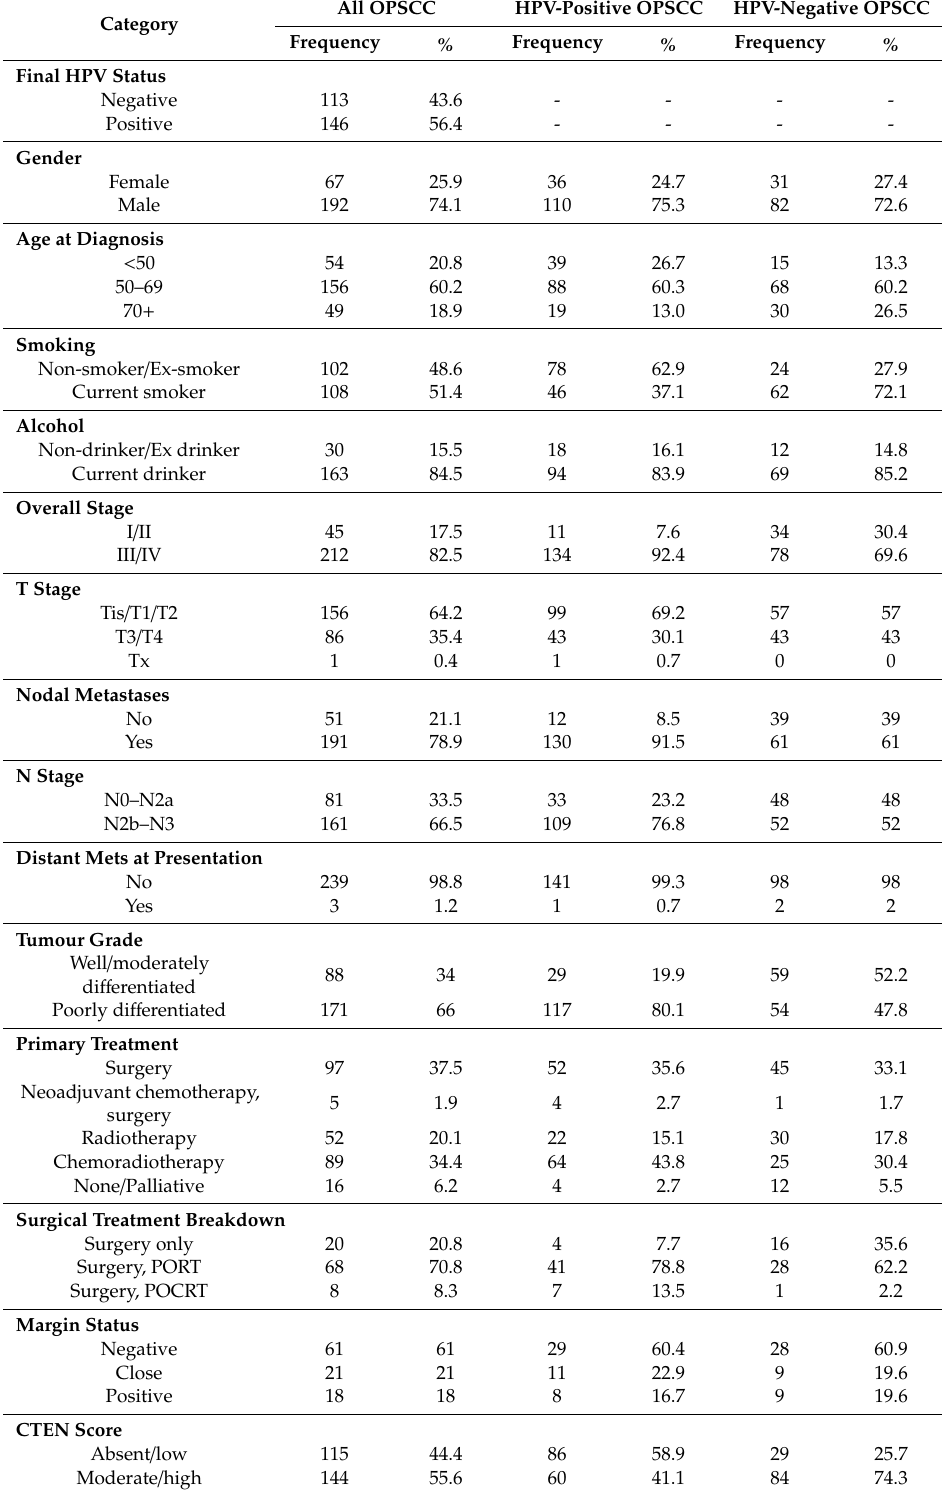
Table 1. Comprehensive oropharyngeal squamous cell carcinoma (OPSCC) database demographics, according to the American Joint Committee on Cancer (AJCC) TNM 7th